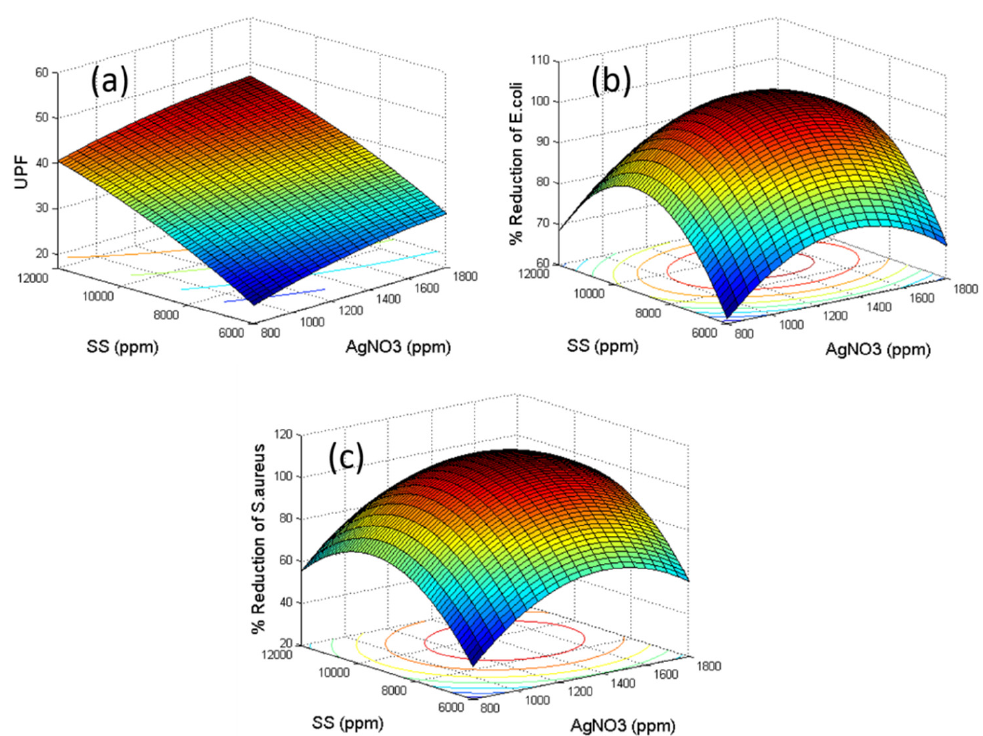
Figure 2. 3D response surface images at different levels of SS and AgNO 3 for ( a ) UPF, ( b ) %reduction of E. coli , and ( c ) %reduction of S. aureus . Table 2. Experimental and predicted response surface methodology (RSM) results for Y 1 , Y 2 , and Y 3 . Table 3. Optimum condition for the properties of UPF and antibacterial activity against E. coli and X 1 and X 2 are the contents of SS (ppm) and AgNO 3 (ppm) respectively. S. aureus of the SS ‐ AgNP sample.